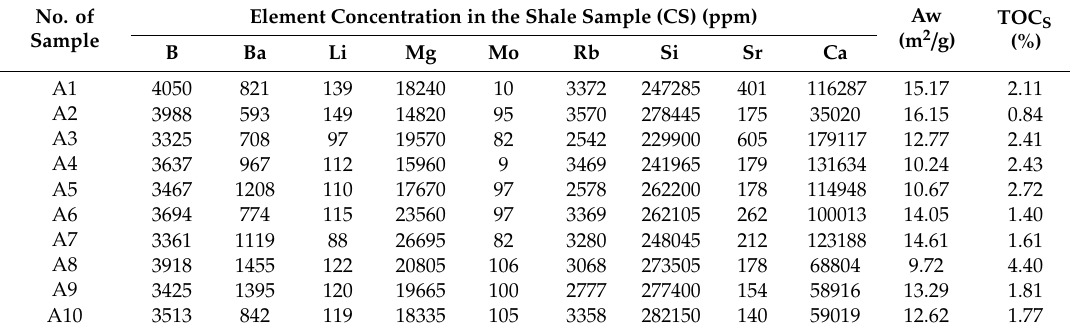
Table 3. Results of elemental analysis of shale samples (A1 ÷ A10) using the XRF